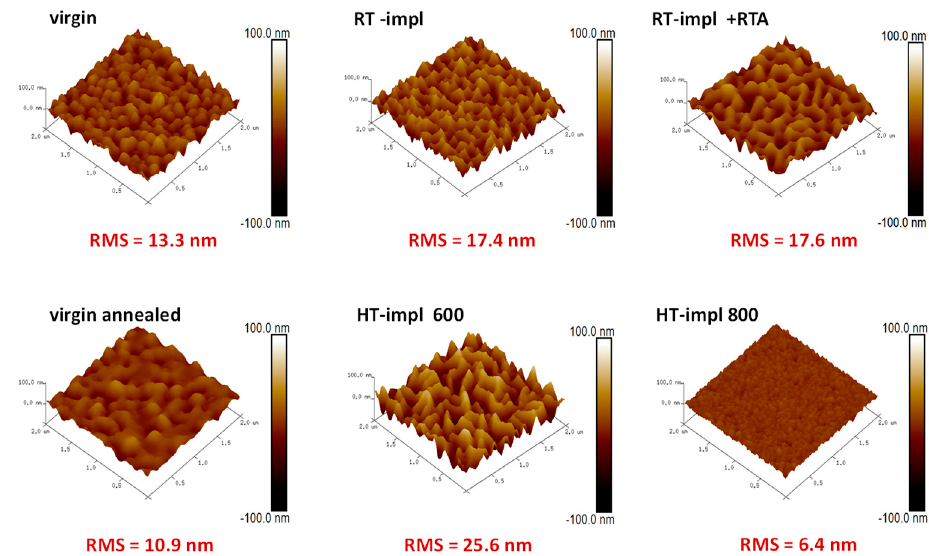
Figure 2. AFM imaging of the surface morphology for ZnO before (virgin) and after implantation at different temperatures with 150 keV Yb ions to the fluence of 1 × 10 15 /cm 2 as well as RT-implanted samples and subsequently RTA-annealed for 10 min at 800 ◦ C in O 2 . The depth distributions of matrix and impurity atoms were specified by RBS. 237